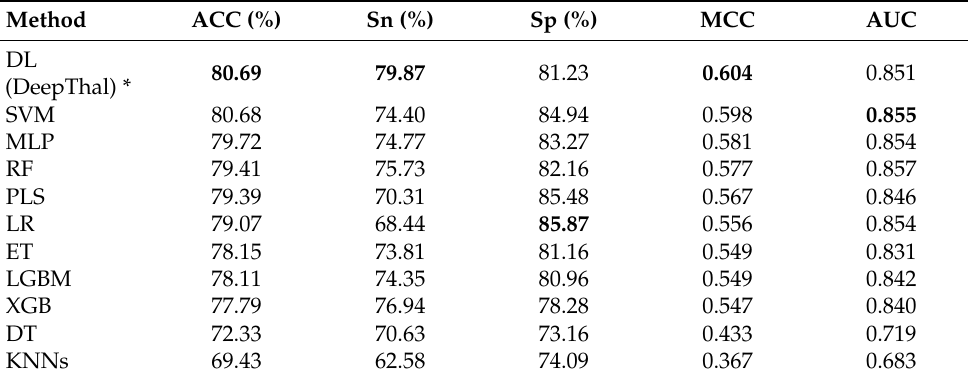
Figure 2. Performance comparison of the top three ML-based models on the training ( A , B ) and independent test ( C , D ) datasets. Prediction results of the top three ML-based models in terms of ACC, Sn, Sp, and MCC ( A , C ). ROC curves and AUC values of the top three ML-based models ( B , D ). SVM, support vector machine; MLP, multilayer perceptron; ACC, accuracy; AUC, area under the curve; MCC, Matthews correlation coefficient; ML, machine learning; Sn, sensitivity; Sp, specificity. Table 4. Cross-validation results of different ML-based predictors in the training